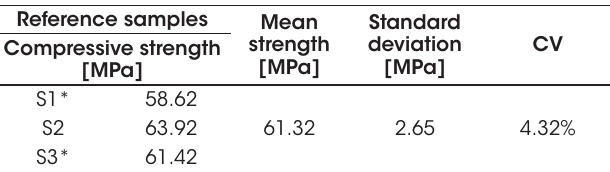
Compressive strength measured in samples cast in